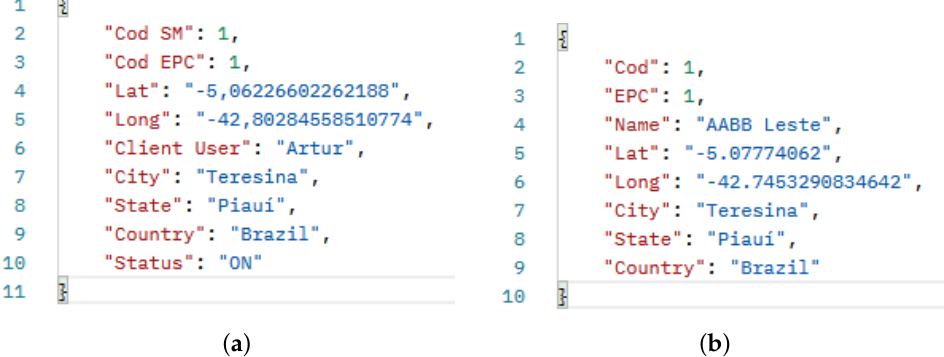
Figure 7. All JSON packages modeled to feed the application database. ( a ) JSON from the left SM table. ( b ) JSON from the front SM table.